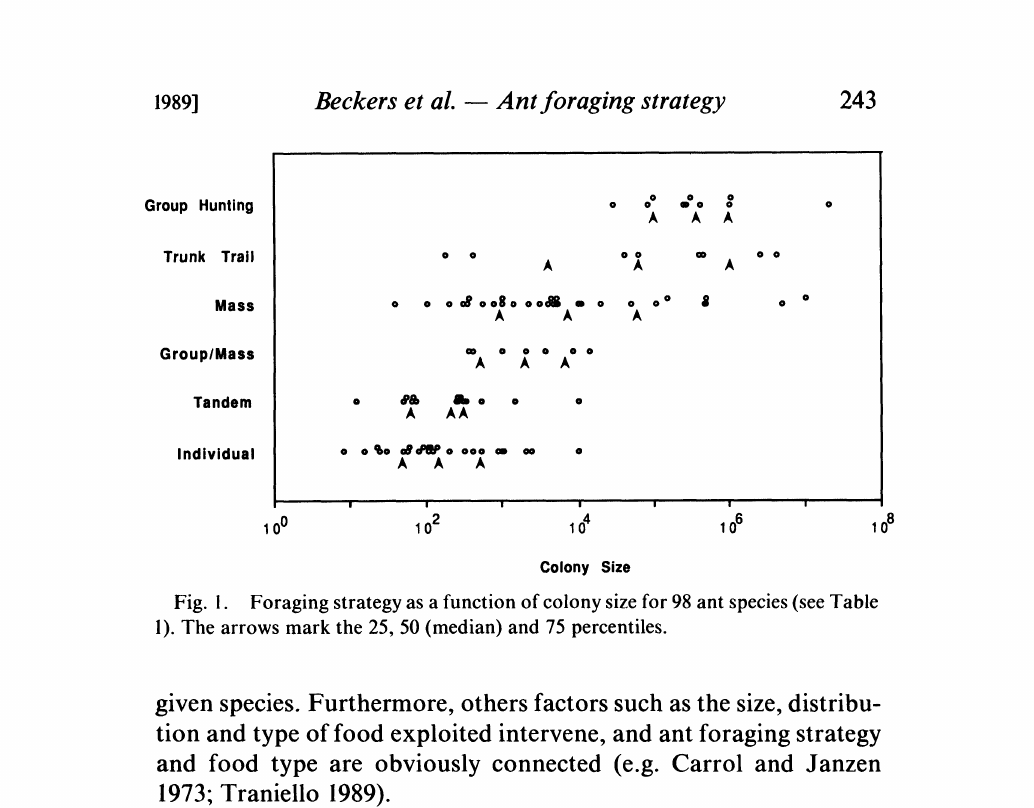
Fig. I. Foraging strategy as a function of colony size for 98 ant species (see Table 1). The arrows mark the 25, 50 (median) and 75